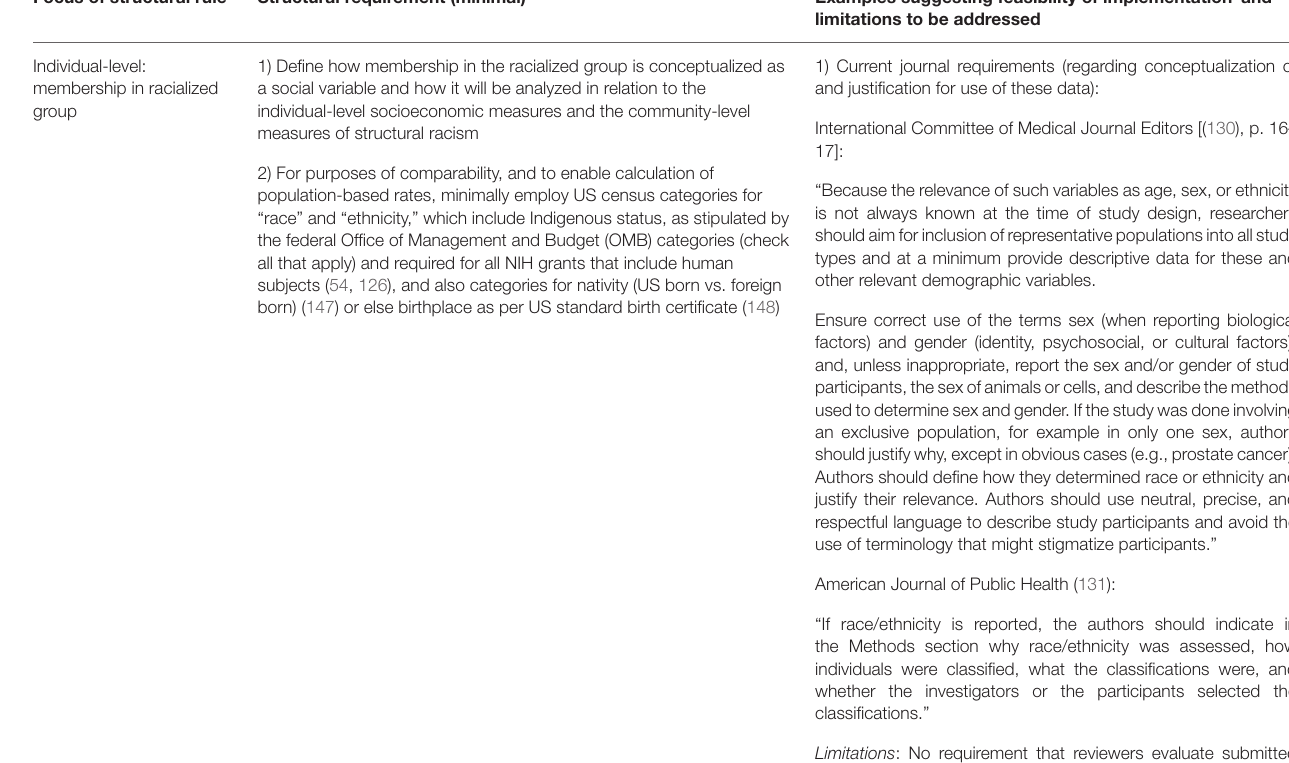
TABLE 1 | Structural solutions to the problems of structural racism and the two-edged sword of data so that it can point to health justice: proposed minimal data requirements for any health agencies, data systems, grant recipients, or journals receiving government support. Focus of structural